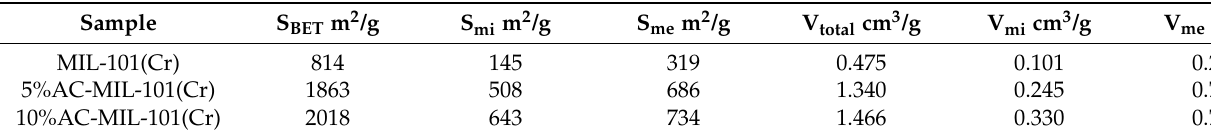
Figure 5. N 2 adsorption–desorption isotherms measured for MIL-101(Cr), 5% AC-MIL101(Cr) and 10% AC-MIL-101(Cr). (Filled symbols represent adsorption and open symbols represent desorption). Table 1. Structural properties of table MIL-101(Cr) and AC-MIL-101(Cr).